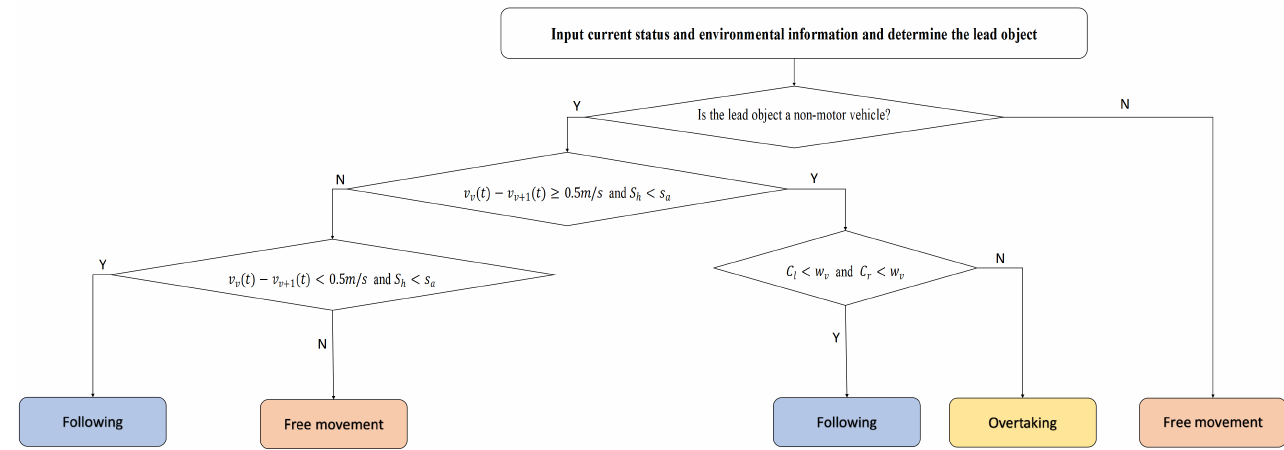
Figure 4. Determining free movement, following and overtaking behavior at one time